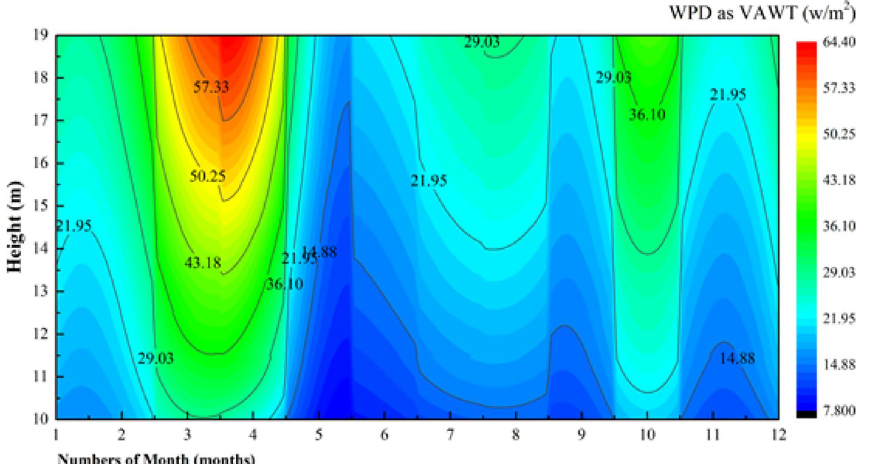
Figure 18. Wind energy density (VAWT) per month at 10–19